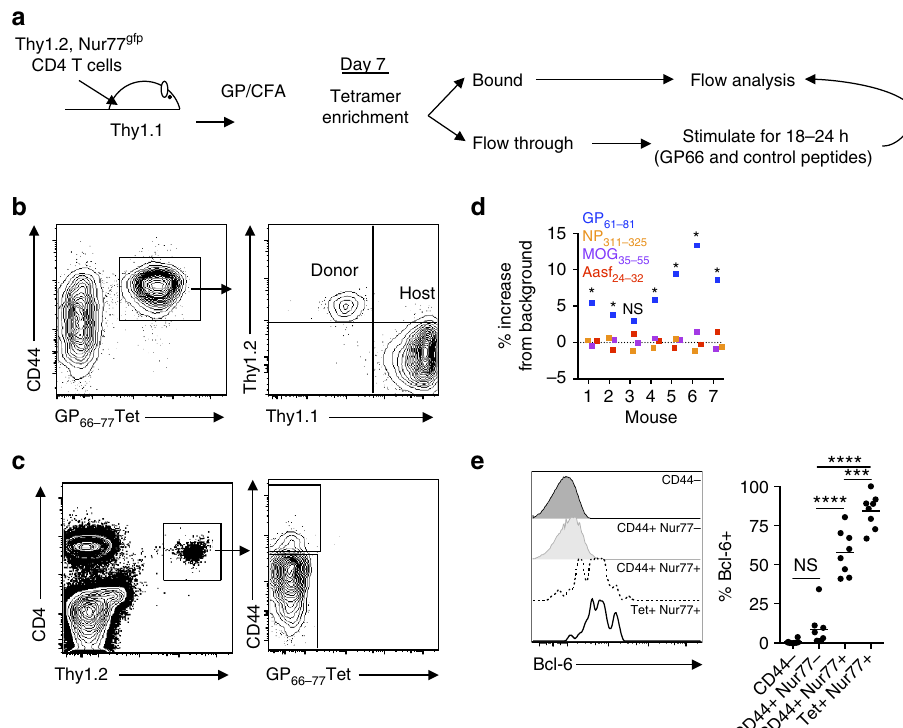
Figure 1 | Tet þ LDA reveals low-affinity CD4 þ T cells in the naive repertoire. ( a ) 6 (cid:3) 10 6 Nur77 gfp CD4 þ T cells (6 (cid:3) 10 5 after a 10% park